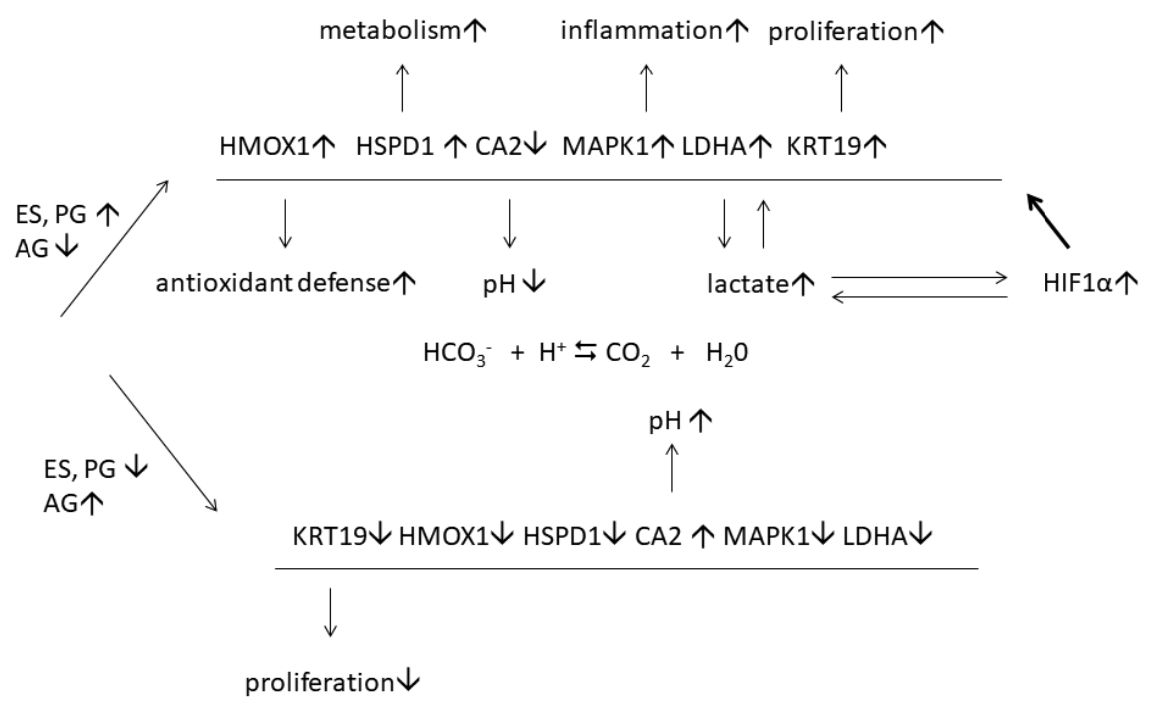
Figure 5. Regulation of estrogen-responsive proteins in lesional skin of female psoriasis patients with and without menopause: the proposed model. The signs ↑ and ↓ indicate that the protein expression is increased and decreased, respectively. The sign (cid:28) indicates that chemical reaction between HCO 3 − and can be